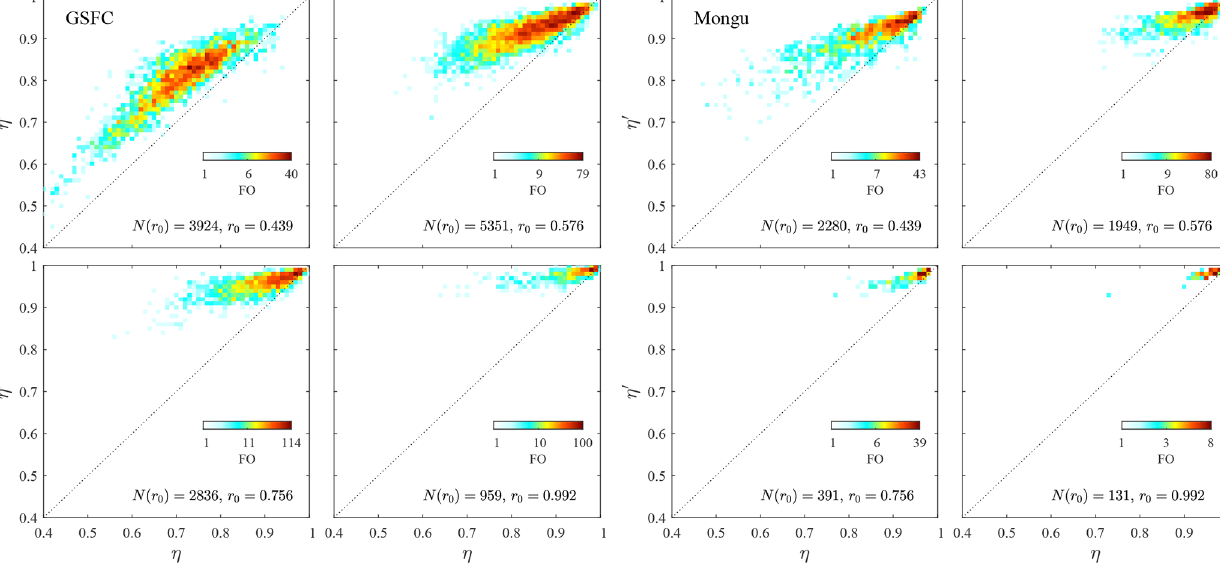
Figure A2. η (cid:48) vs. η FO distributions for GSFC and Mongu. See the caption of Fig. A1 for FO and N(r 0 ) details.